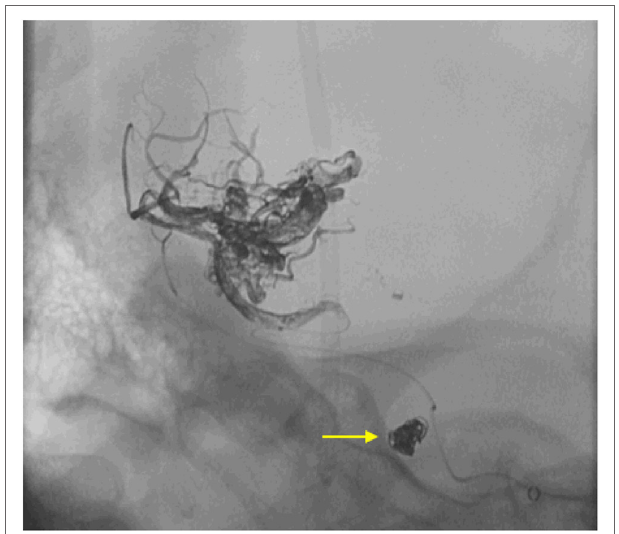
FIguRe 3 | Final run X-Ray demonstrating the position and configuration of the platinum coils inside the sac of the aneurysm (yellow arrow) as well as the ONYX filling the vascular channels of the arteriovenous malformation after the procedure.